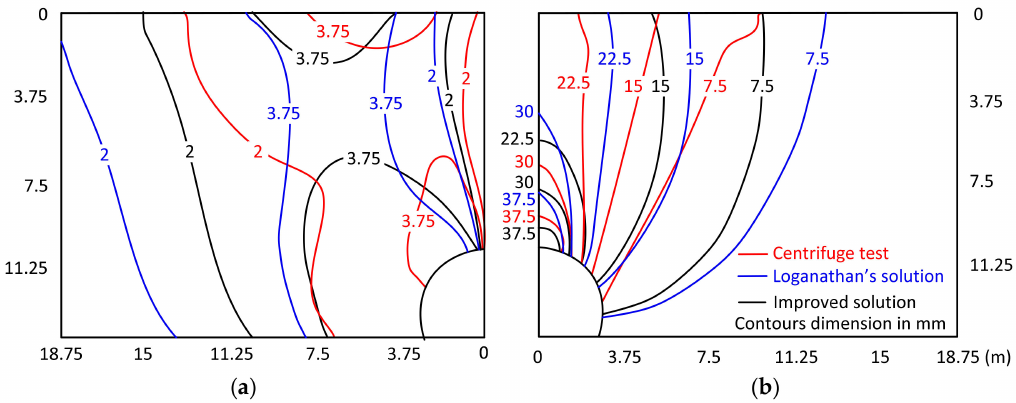
Figure 7. Contour comparison of Loganathan’s solution, theorical calculation of this paper, and centrifugal test results (2.5% volume loss): ( a ) Horizontal displacement contours for Greenfield; ( b ) vertical displacement contours for